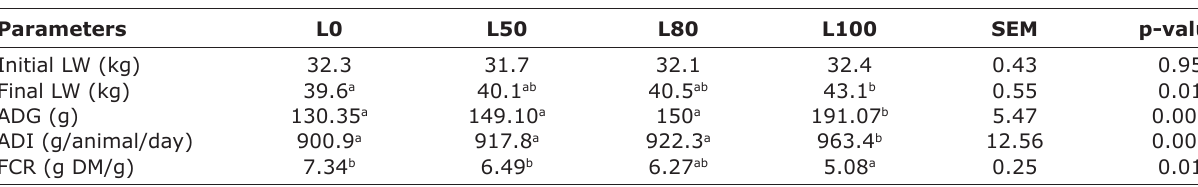
Table-6: Fattening performances of Ouled Djellal lambs.